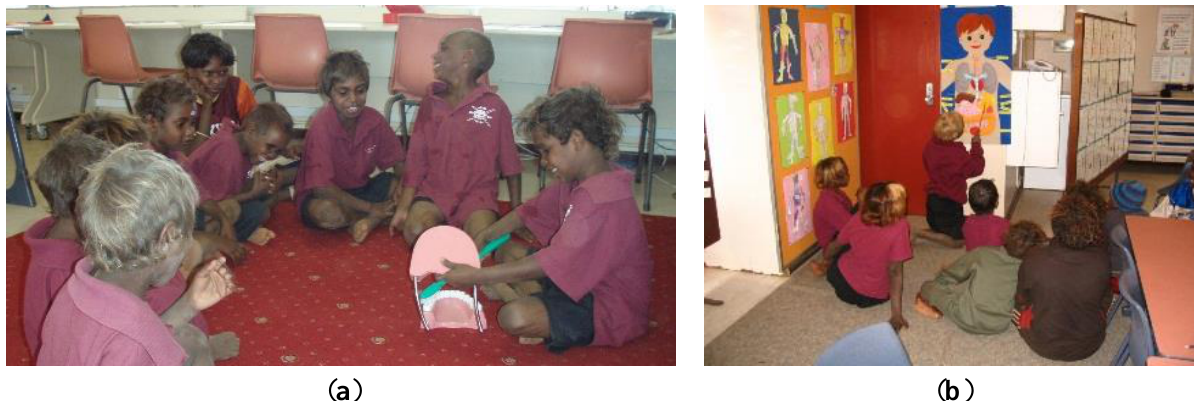
Figure 5. ( a ) Demonstrating oral hygiene; ( b ) Explaining the digestive